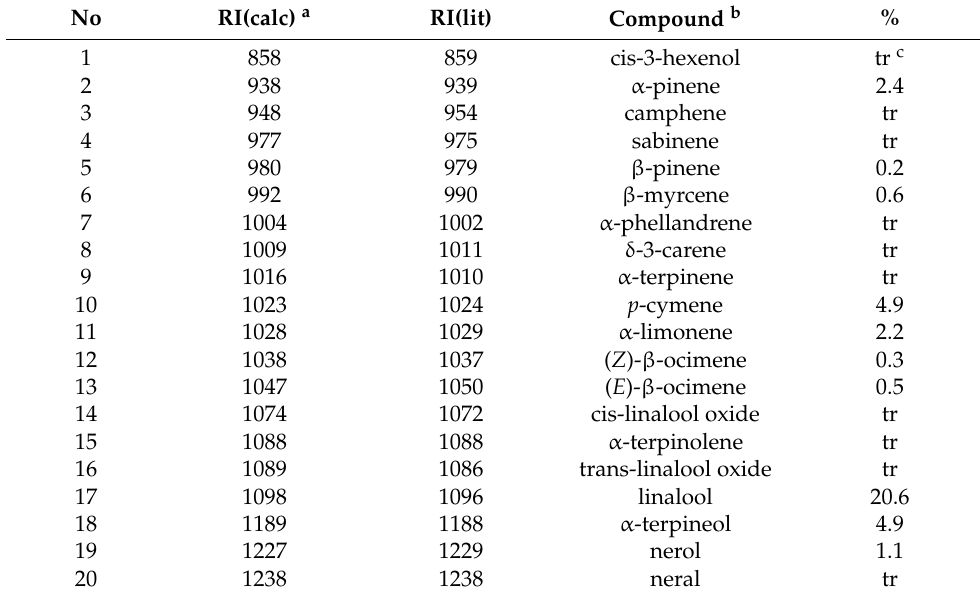
Table 1. Chemical composition of